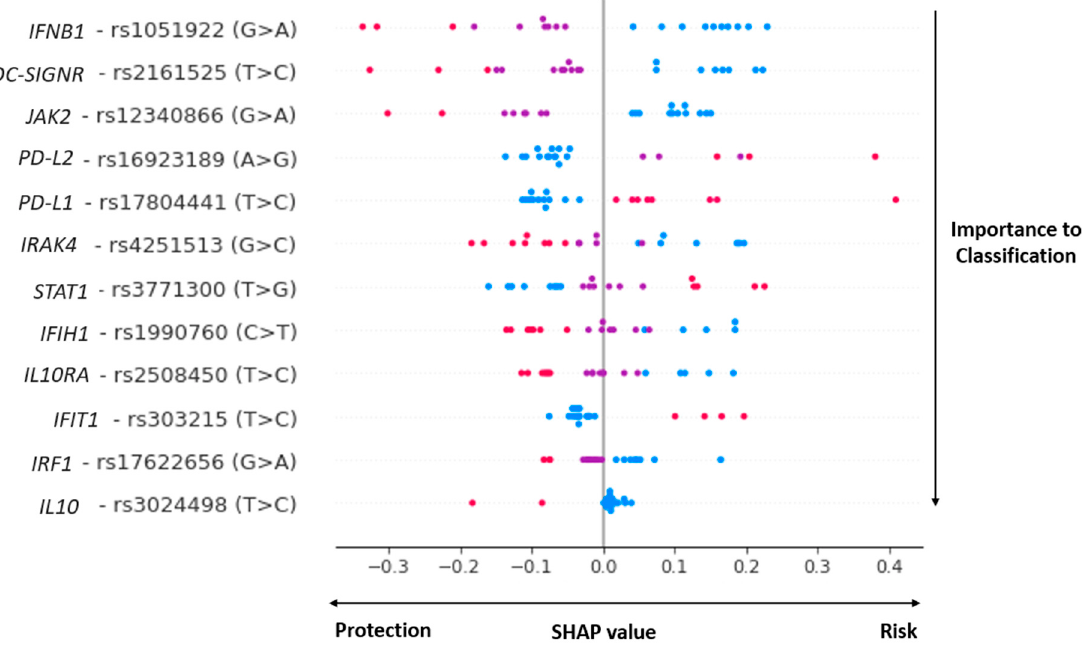
Figure 1. The general impact of each human genotype on genome polymorphisms -ML COVID-19 prognosis classifier under SHAP (Shapley Additive exPlanations) analysis. The impact of each selected genotype (feature) on genome polymorphisms/machine learning model output (mild or severe COVID-19 cases). In blue, reference homozygotes; in purple, heterozygotes; in pink, alternative homozygotes. The figure depicts SHAP analysis over test dataset only–some alleles may not appear with all three values.